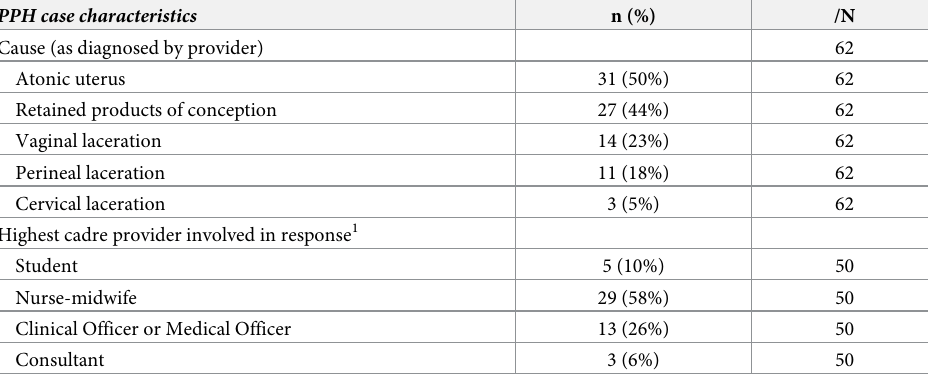
Table 2. Characteristics of observed PPH